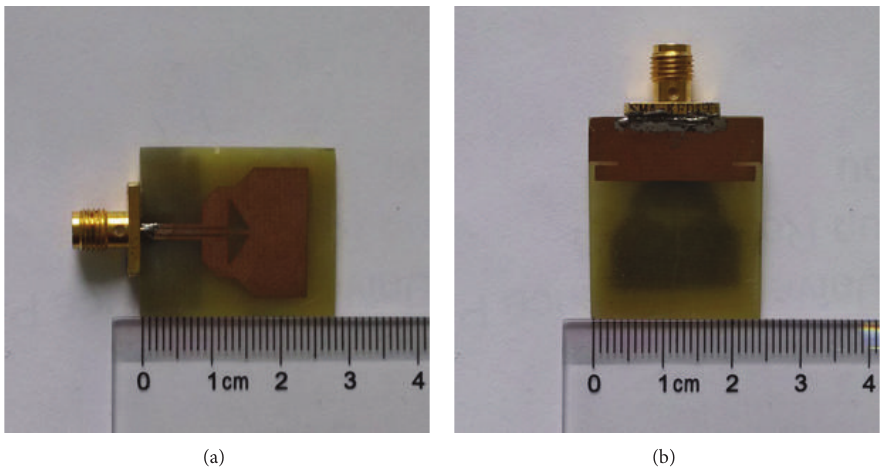
Figure 11: Prototype of the proposed antenna: (a) top view and (b) bottom view.